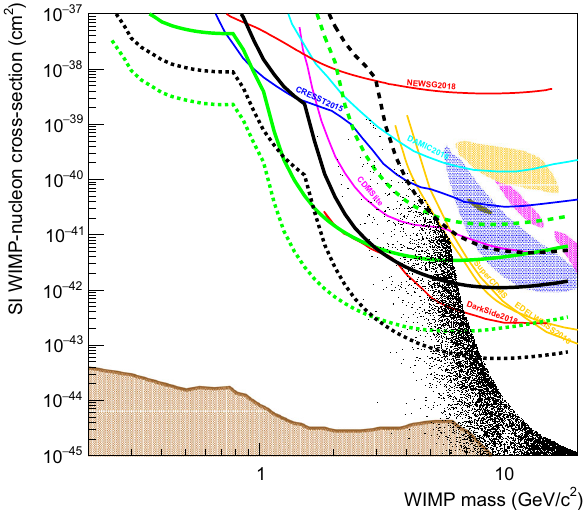
Fig. 9 90% CL sensitivity of TREX-DM under three different condi- tions for background level, energy threshold and exposure, summarized in Table 6, for Ar + 1%iC 4 H 10 (black lines) and Ne + 2%iC 4 H 10 (green lines). The closed contours shown correspond to results from CDMS-II Si [78] (blue, 90% CL), CoGeNT [2] (dark gray, 90% CL), CRESST-II [79] (magenta, 95% CL), and DAMA/LIBRA [80] (yellow, 90% CL). Thebrownshadedregioncorrespondstothesensitivitylimitimposedby the solar neutrino coherent scattering background [81]. As a reference, 90% CL exclusion limits from different experiments are also shown: CRESST-II 2016 [7] (dark blue), CDMSlite [5,6] (purple), DAMIC [3] (light blue), EDELWEISS [9] and SuperCDMS [82] (yellow) and DarkSide [12] and NEWS-G [13] (red)